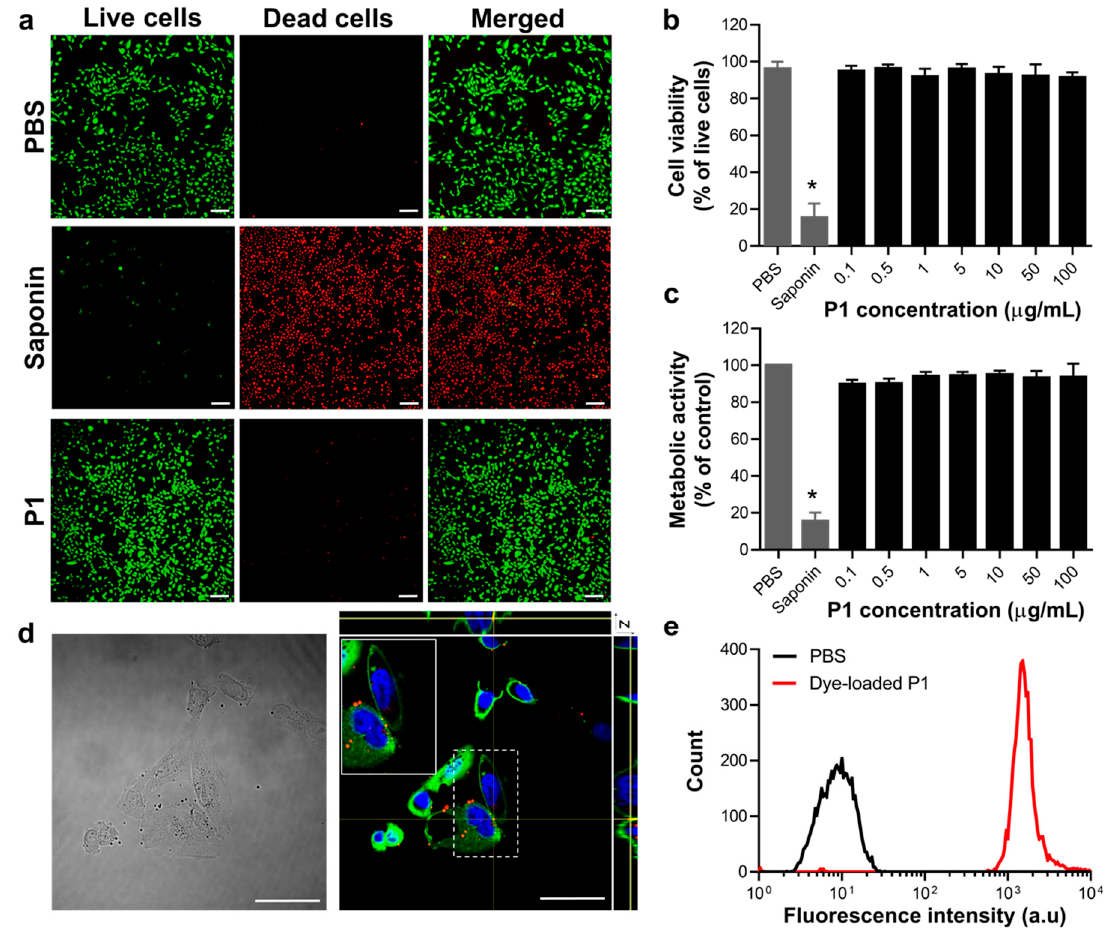
Figure 5. ( a – c ) CHO-K1 cells were treated for 24 h with increasing concentrations of P1 and cell viability was measured by means of the ( a , b ) live/dead assay and by ( c ) resazurin-based metabolic activity. ( a ) Representative fluorescence microscopy images showing the distribution of lived (green; calcein AM) and dead (red; ethidium homodimer) cells after treatment with particles (100 µg/mL). The scale bar is 100 µm. ( b , c ) The data represent mean ± S.D. of at least three independent experiments performed in triplicate. The results were analyzed using the Student’s t-test and the statistical difference (between vehicle-treated control cells (PBS) and treated cells) was established at * p ˂ 0.01. ( d ) Representative differential interference contrast (DIC) and fluorescence confocal microscopy images of CHO-K1 after 4 h incubation with 100 µg/mL of dye-loaded particles (red). The plasma membrane is stained in green and the cell nucleus in blue. The scale bar is 50 µm. ( e ) A flow cytometry diagram showing the plasma membrane adsorption and cellular uptake of dye-loaded P1 .